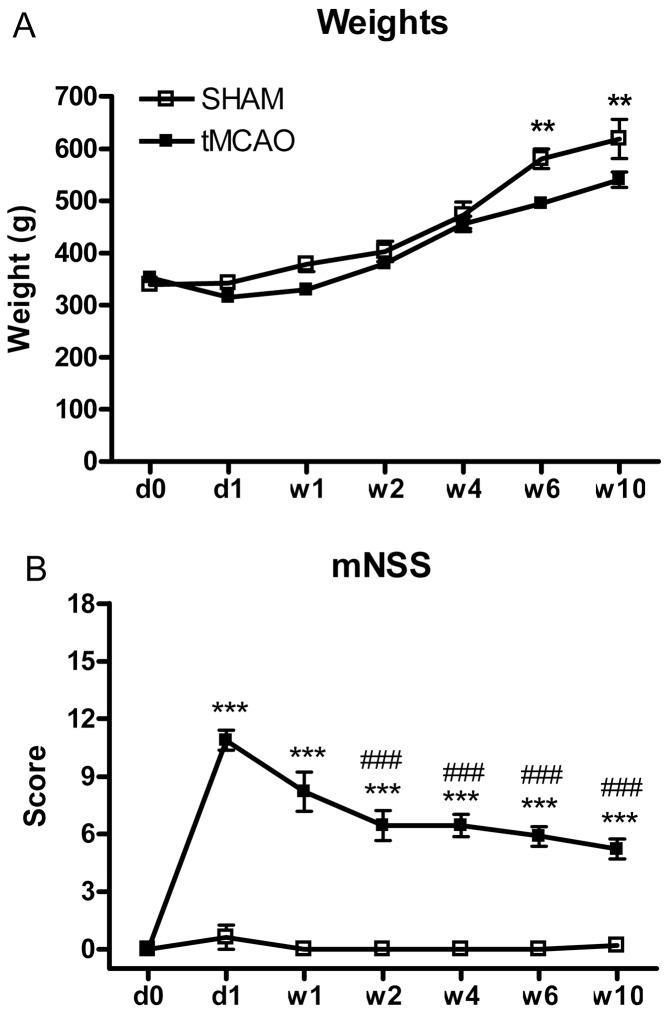
Body weight and composite mNSS score was measured for 10 weeks after tMCAO.The time points for the observation are before the surgery (d0) and at d1 and at w1, w2, w4, w6 and w10 after tMCAO. A: tMCAO surgery did affect body weight immediately after surgery. However, tMCAO did result in a small reduction weight gain at w6 and w10 (i.e., failure to gain as much weight as Sham Surgery rats). B: mNSS was persistently higher than the control group after stroke for the full 10 weeks of observation. However, there was some spontaneous recovery of function over time (i.e., reduced by about 50% of the original post-stroke deficit at d1). **p<0.01, ***p<0.001 vs. sham group at the corresponding time point. Two-way ANOVA with Bonferonni post-hoc test procedure (n = 8–9 rats/group). ###p<0.001 vs. tMCAO group at d1 after stroke. One-way ANOVA with Newman–Keuls test procedure (n = 8–9 rats/group).